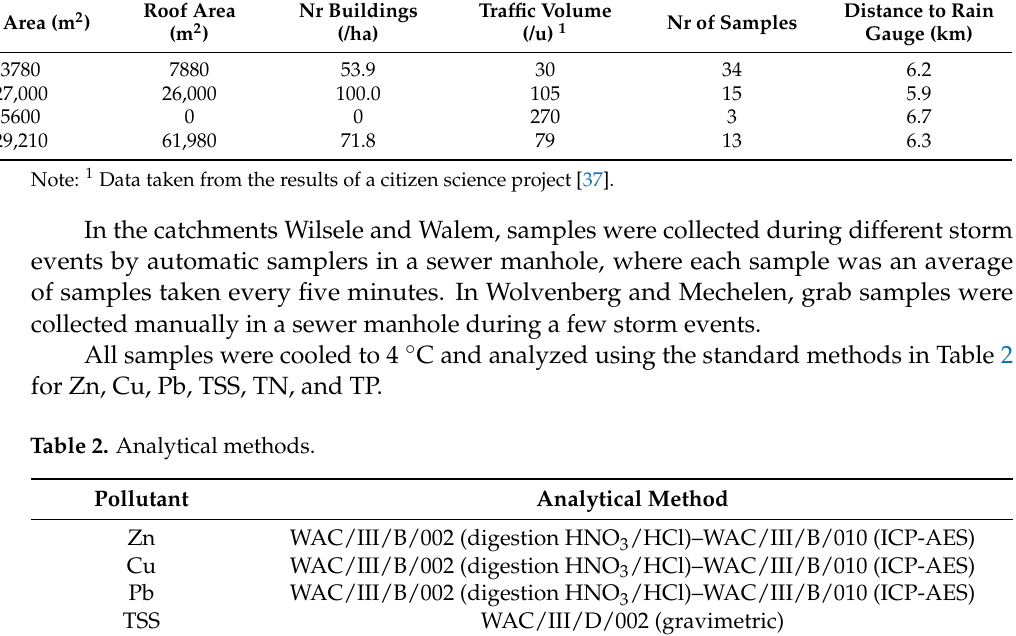
Table 1. Details of the catchments.